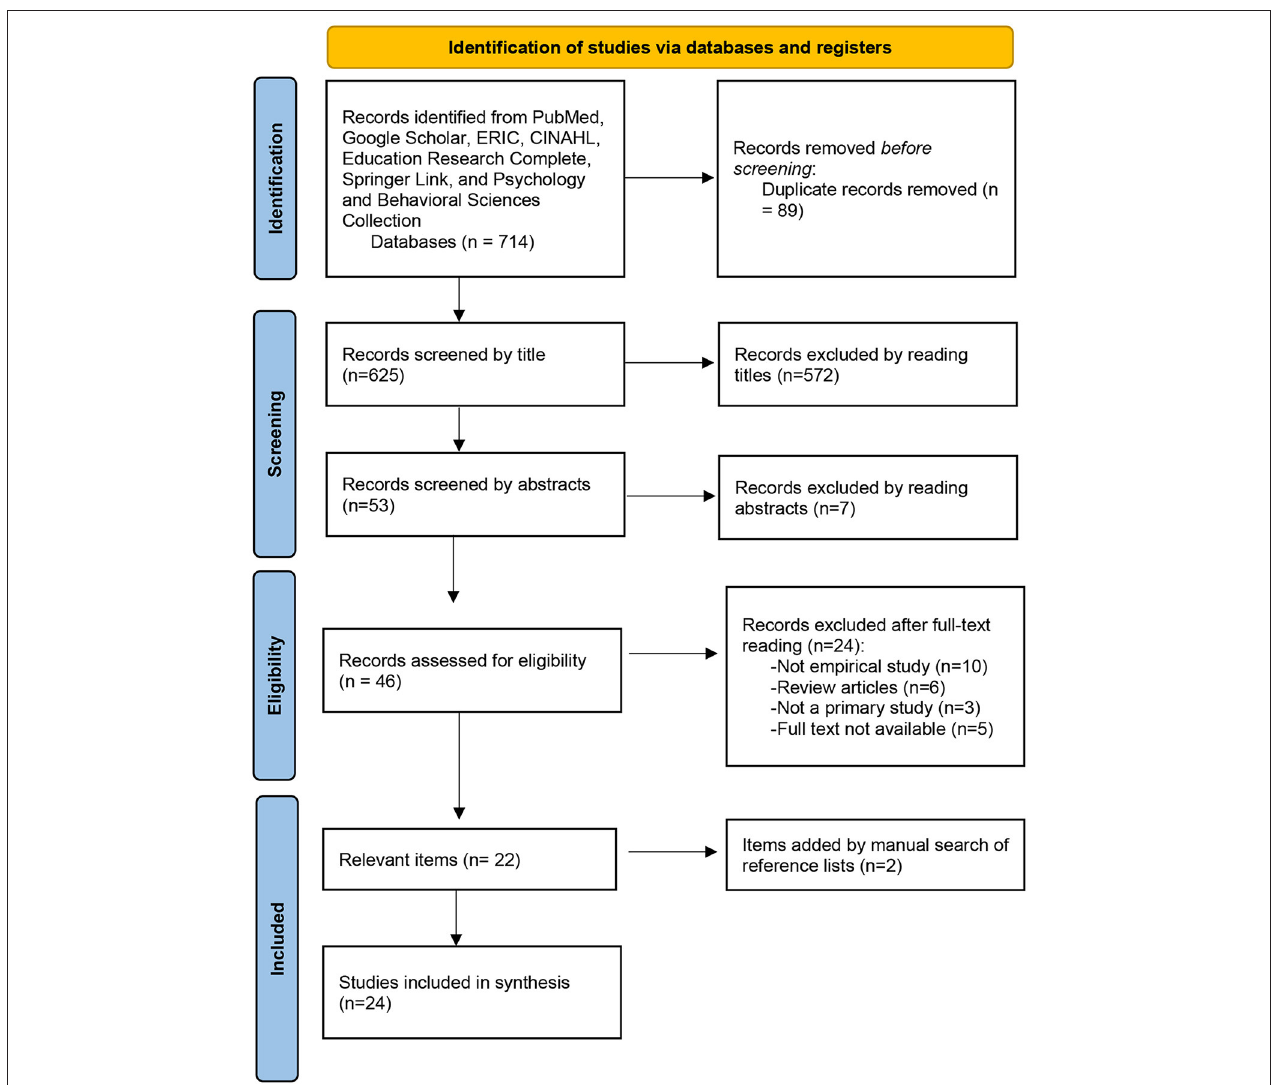
FIGURE 1 | PRISMA flow chart of the study identification